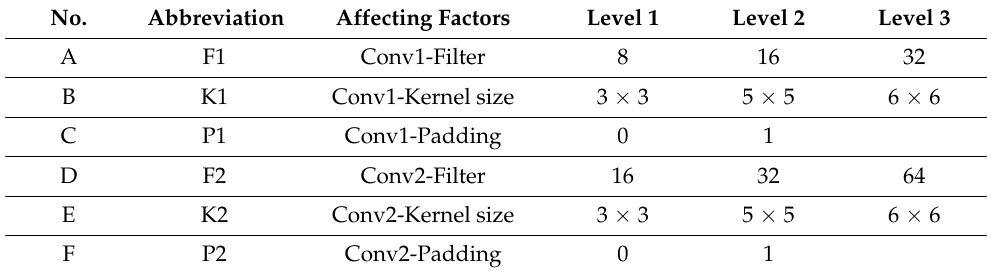
Table 5. Affecting factors and their levels.